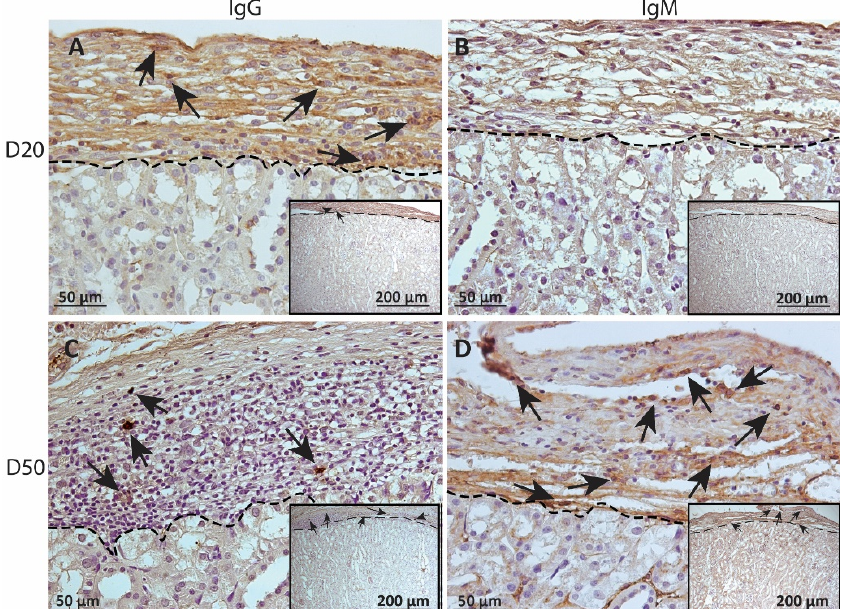
Figure 6. Immunohistochemical analysis of antibody deposition on MSC1 chronic timepoint allografts. Graft-bearing MSC1 kidneys were collected at days 20 ( A , B ) and 50 ( C , D ) post-transplantation and tissue sections were immunostained for IgG (brown; A , C ) and IgM (brown, B , D ). Insets are lower magnification. A dotted line separates the graft from the kidney. Sections were counterstained with hematoxylin (blue). Arrows indicate examples of positive staining.